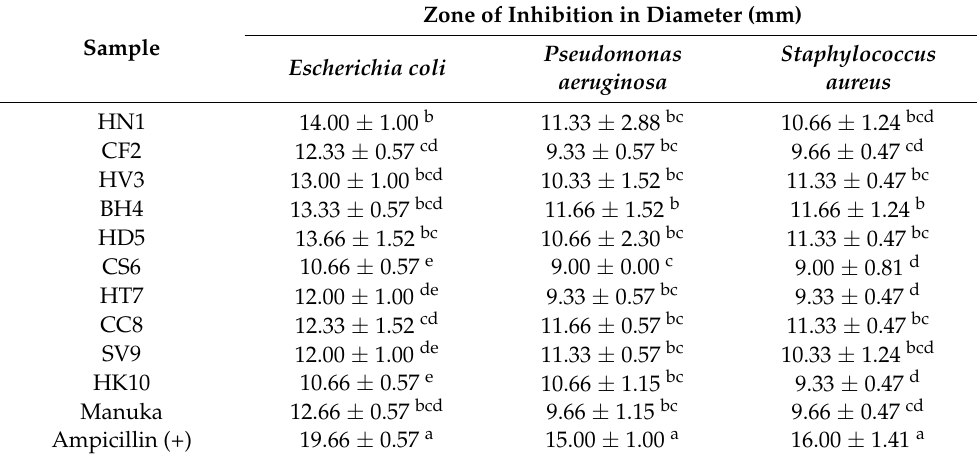
Table 9. Average diameter (mm) of bacterial inhibition zone of different types of